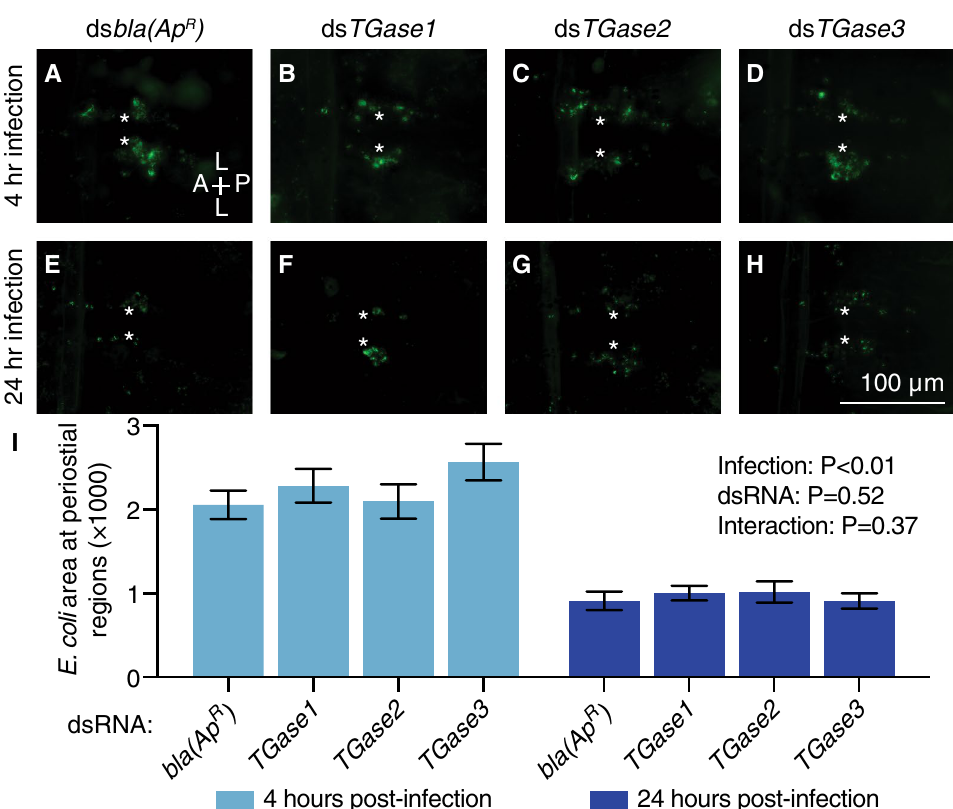
Figure 4. RNAi-based knockdown of transglutaminase genes does not alter the accumulation of GFP- E. coli in the periostial regions. ( A–H ) Fluorescence images show a single abdominal segment with phagocytosed bacteria (green) surrounding the ostia (asterisks) in mosquitoes that had been infected with GFP- E. coli for 4 ( A – D ) or 24 h ( E – H ). Prior to treatment, mosquitoes had been injected with ds bla(Ap R ) ( A , E ), ds TGase1 ( B , F ), ds TGase2 ( C , G ) or ds TGase3 ( D , H ). A, anterior; P, posterior; L, lateral. ( I ) Graph shows the average area of GFP- E. coli in ds bla(Ap R )- , ds TGase1- , ds TGase2- and ds TGase3- injected mosquitoes that had been infected with GFP- E. coli for 4 or 24 h. Data were analyzed by two-way ANOVA, using ds bla(Ap R ) mosquitoes as the reference. Column heights mark the means, and whiskers show the